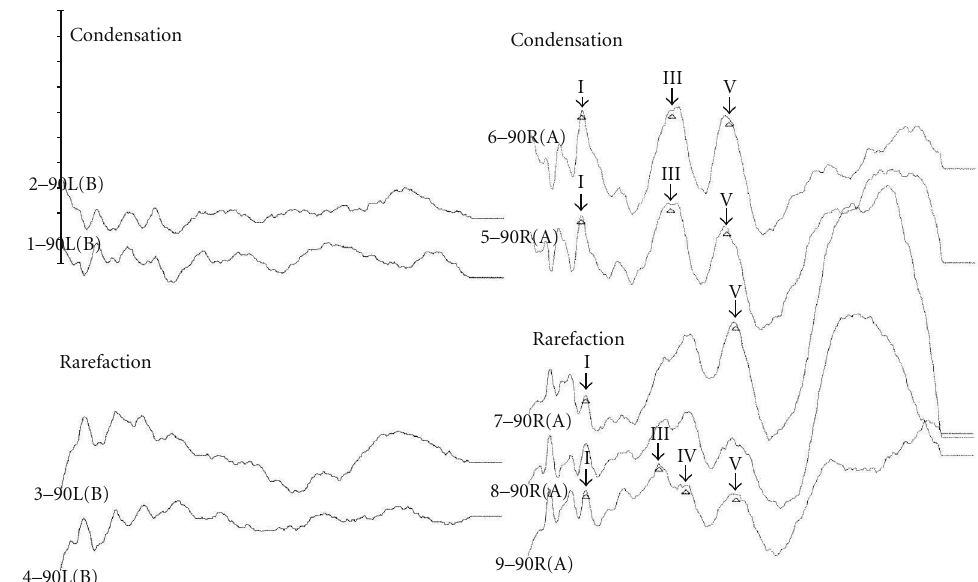
Figure 2: Markedly abnormal auditory brainstem response waveform morphology showing the absence of neural components with only the cochlear microphonic present in an ear with auditory neuropathy/dyssynchrony syndrome for the left ear.